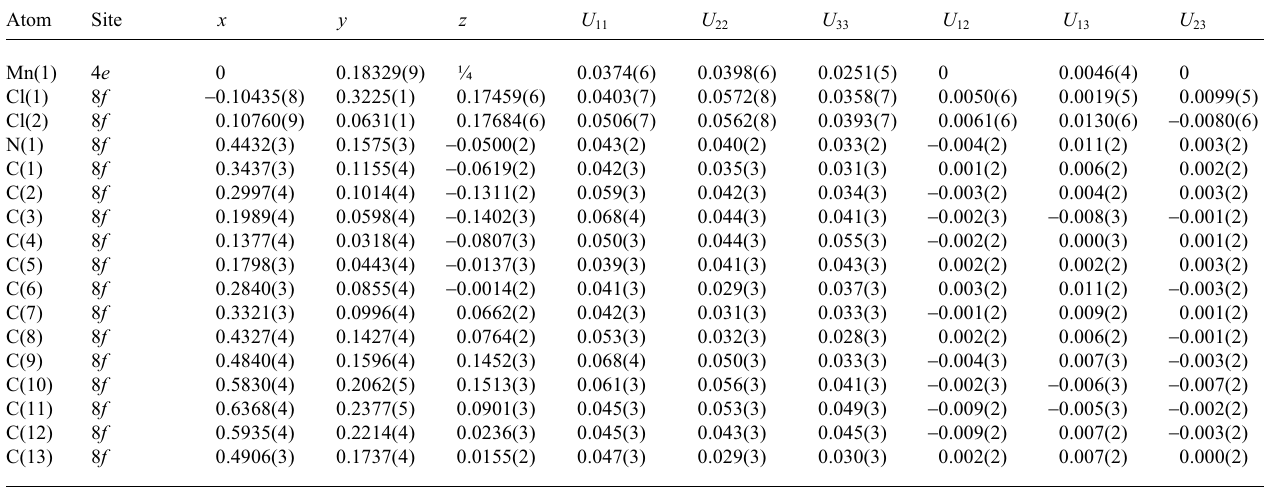
Table 3. Atomic coordinates and displacement parameters (in Å 2 ) .